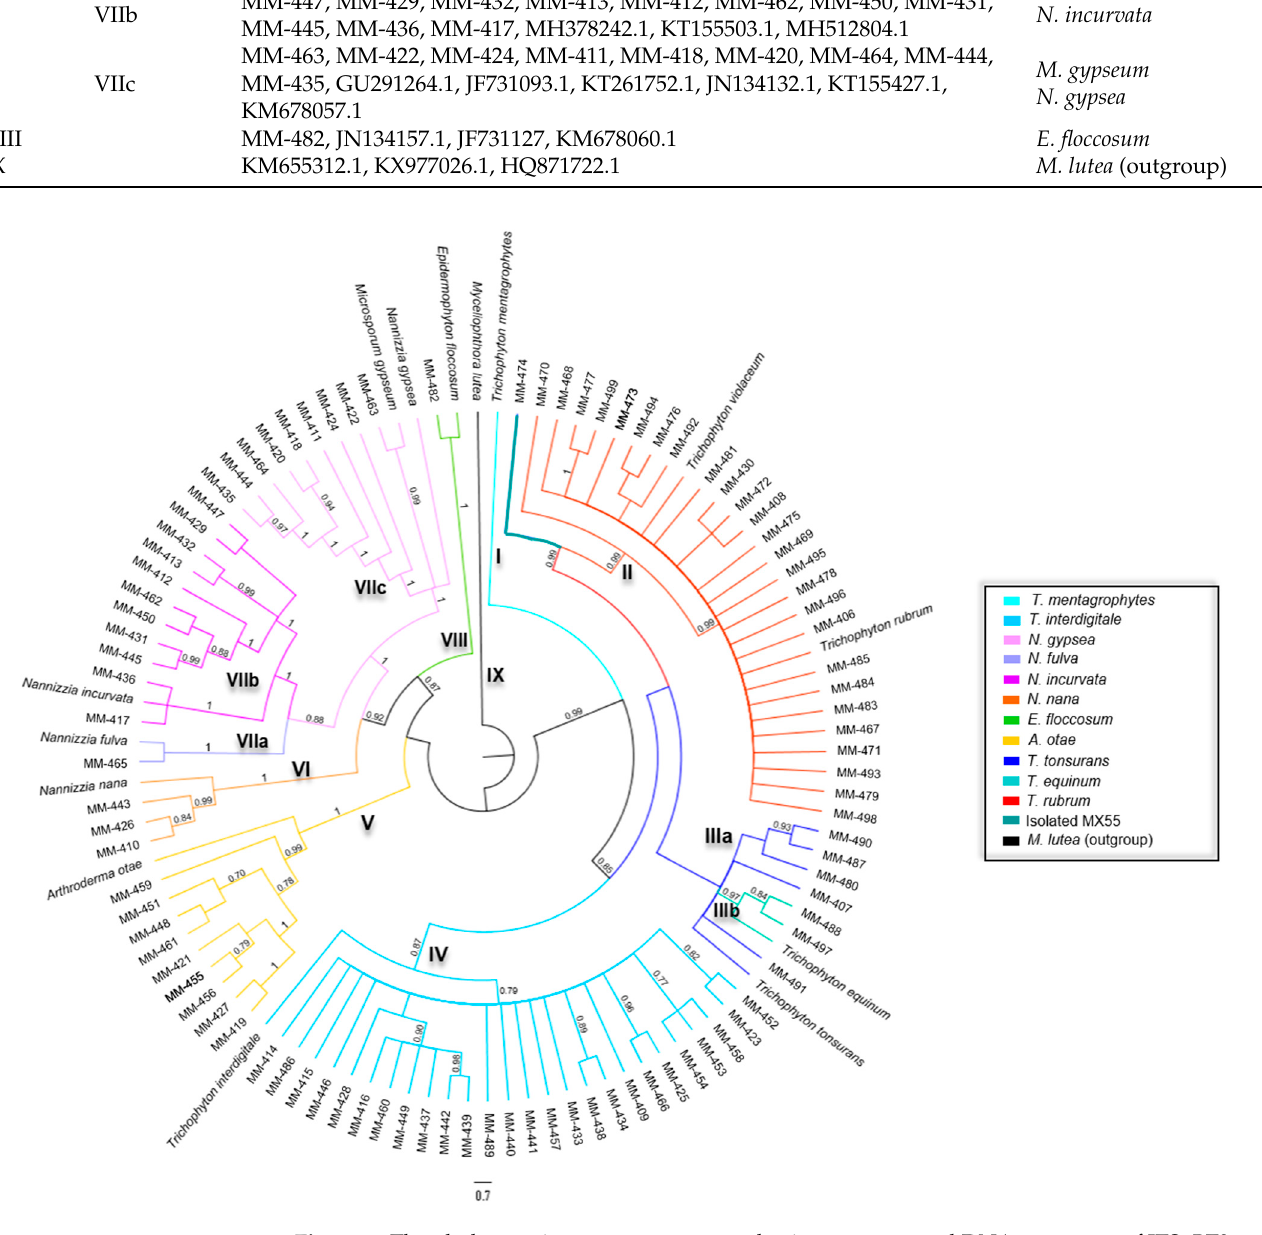
Figure 2. The phylogenetic tree was constructed using concatenated DNA sequences of ITS, BT2 , and Tef-1 α markers of dermatophyte species based on Bayesian inference using the MrBayes program with one million generations. Supporting values of posterior probability are displayed on nodes. Table 4. Genotypic identification of dermatophyte isolates included in the study by Bayesian infer- ence.